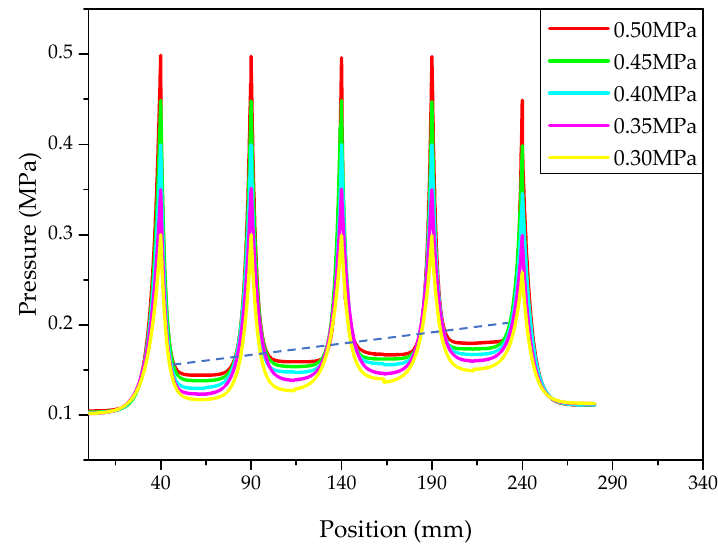
Figure 12. Effect of the supply pressure on the surface pressure of an air film in an unbalanced state.